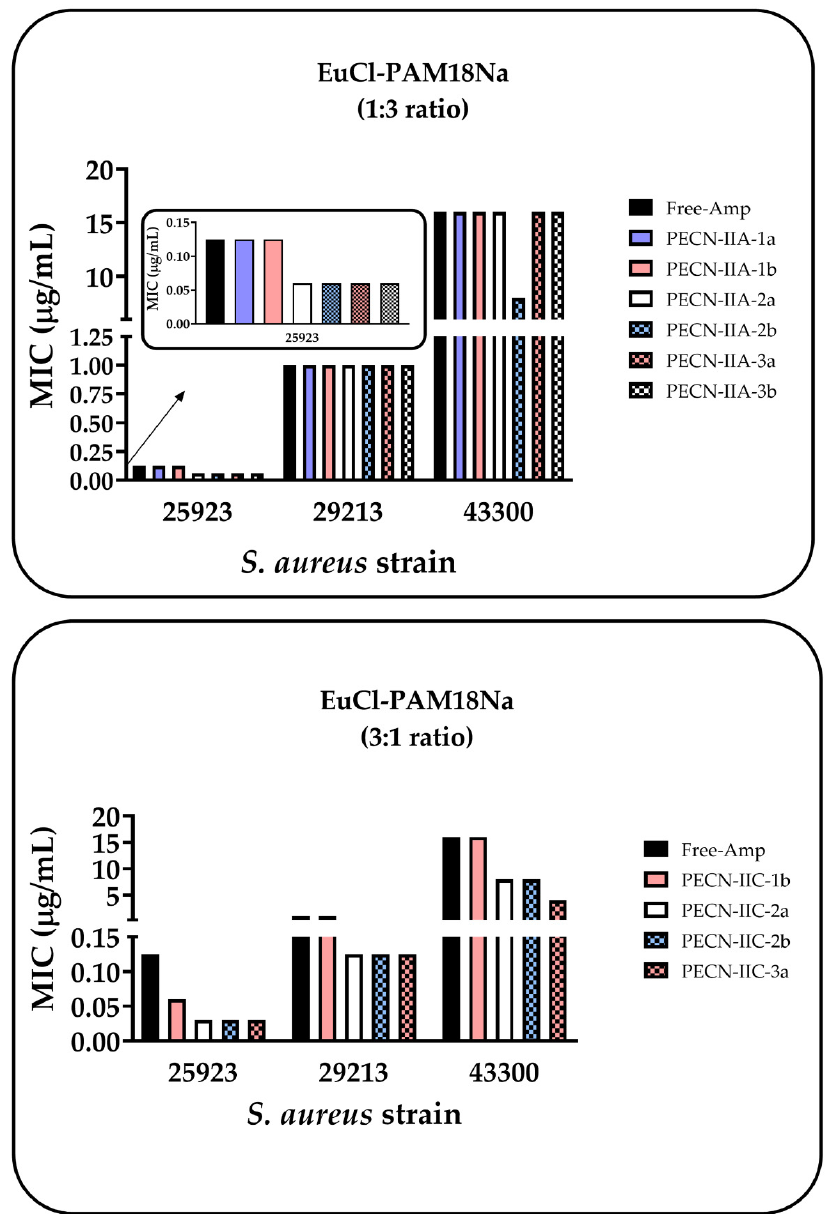
Figure 7. Antibacterial activity of the polyelectrolyte complexes that comply with the physicochemical quality criteria against S. aureus ATCC 25923, 29213, and 43300.